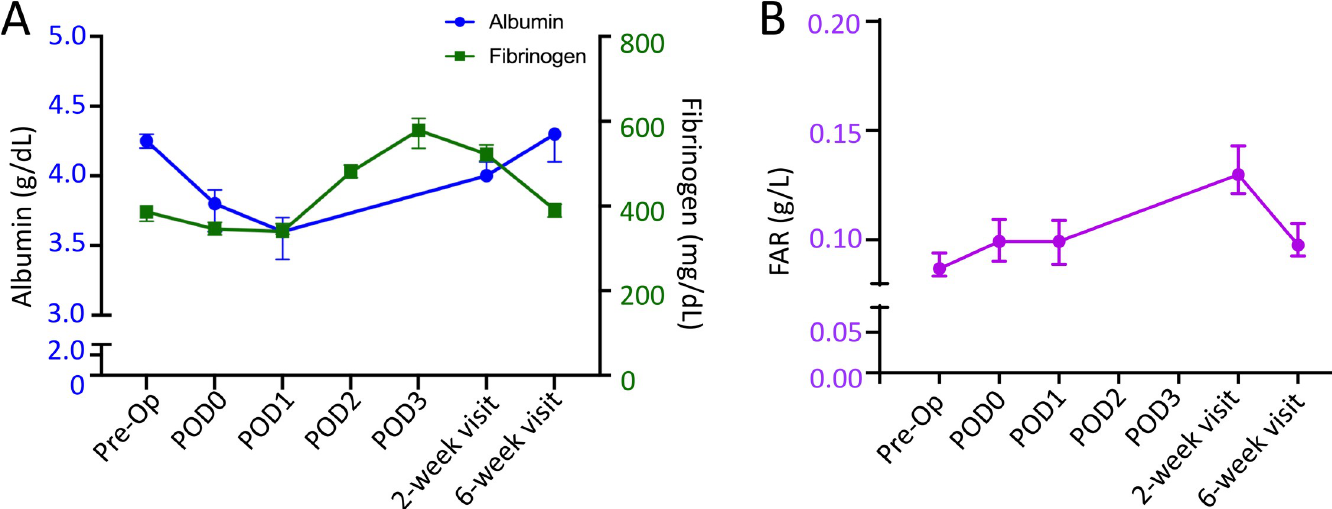
Fig 2. A) Median circulating albumin (blue circle) and fibrinogen (green square) following TKA. r = 0.29. B) Median fibrinogen/albumin ratio (FAR) following TKA. Y-error bars depict a CI of